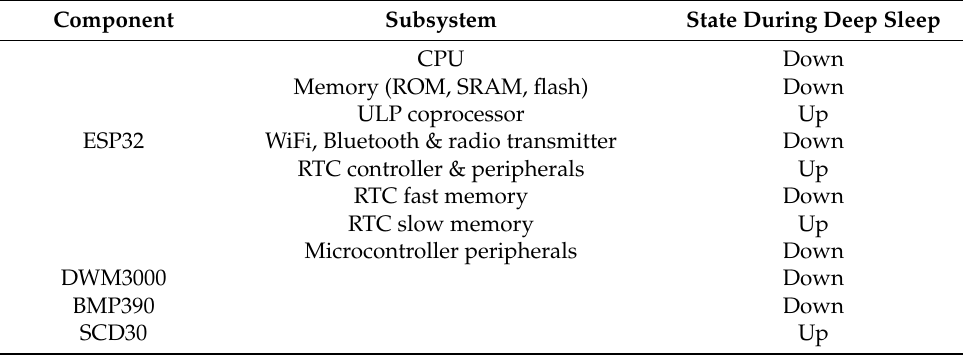
Table 2. State of sensor node components during sleep